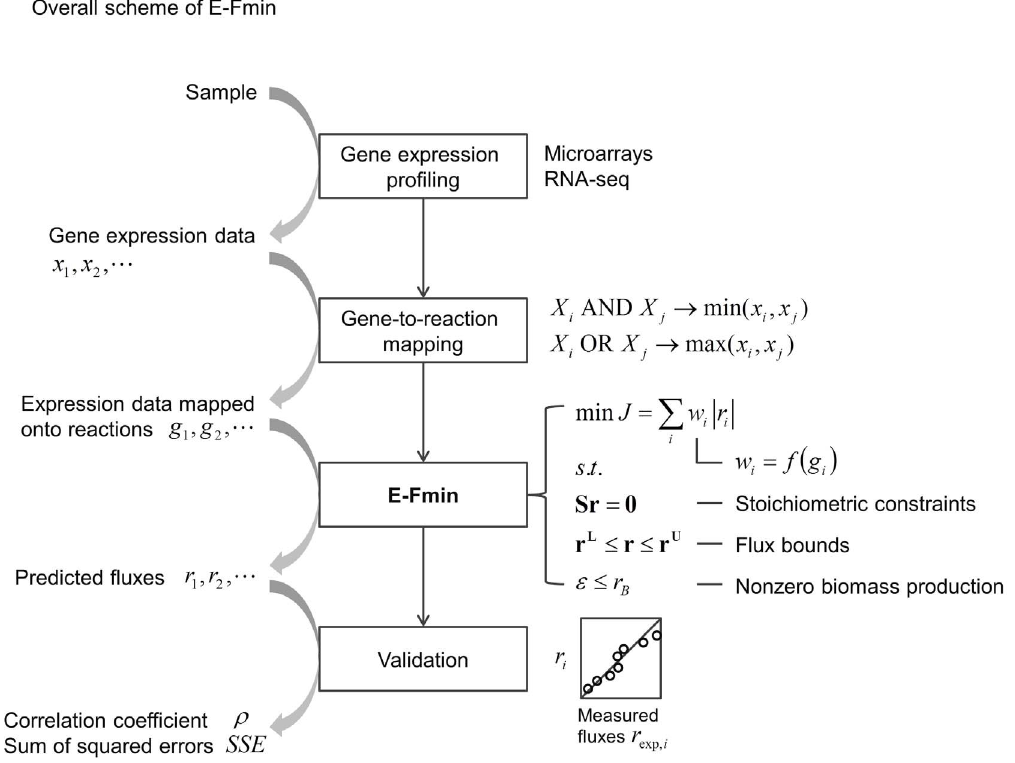
Figure 1. Schematic description of the E-Fmin framework. The algorithm was implemented through the following procedures. The first step was to obtain absolute gene expression profiles in a given condition from microarray, RNA-seq, or other high-throughput methods. Second, gene expression profiles were mapped onto individual reactions using gene-reaction associations. Third, the mapped expression data were integrated with the network model, and the optimization problem is solved to predict the flux distribution. Finally, model predictions were validated by comparison with experimentally measured flux data. The performance of model prediction can be gauged using standard measures, such as correlation coefficients (denoted by r ) and sum of squared error (SSE).